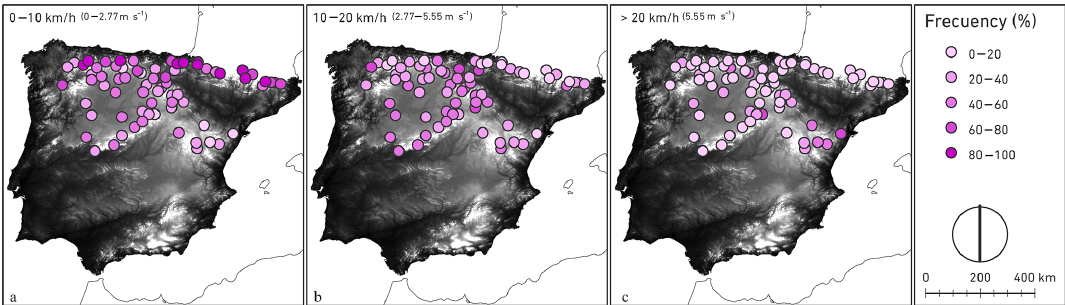
Figure 8. Percentage of 1h snowfall events per station at different wind speed intervals.